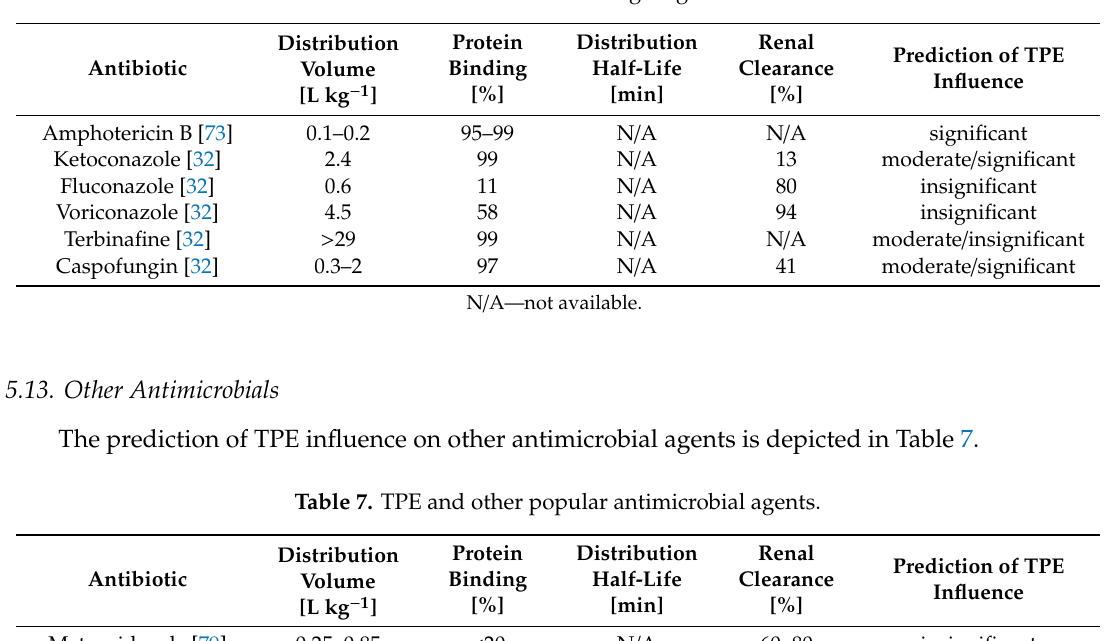
Table 6. TPE and antifungal agents.